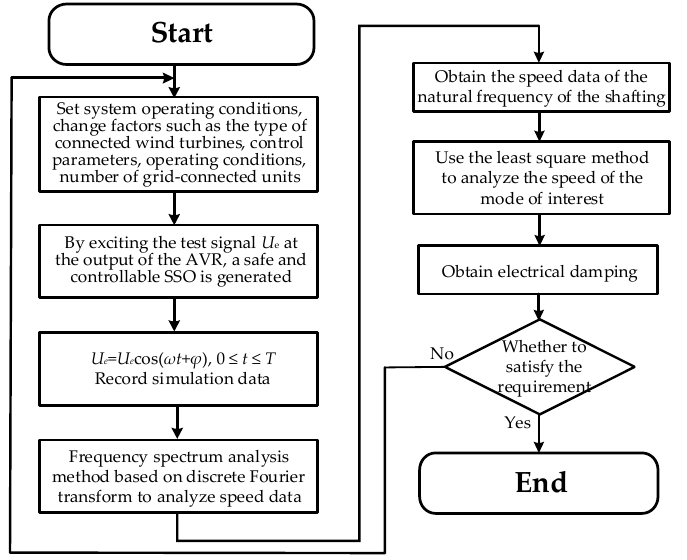
Figure 6. Flowchart of the proposed identification approach.